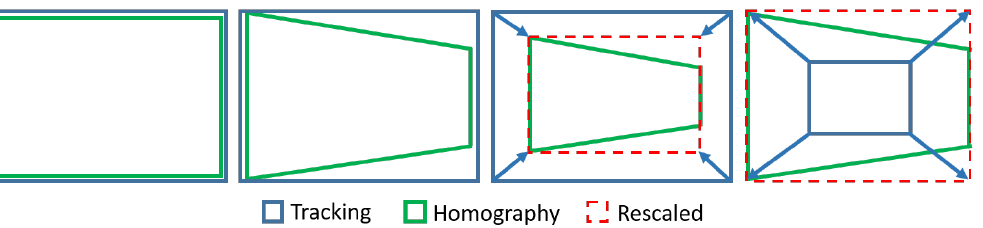
Figure 3. Left to right: Initial state; Rotation and/or translation in the same direction; Reduction of the region of interest (ROI) due to estrangement; Increased ROI due to the approach.